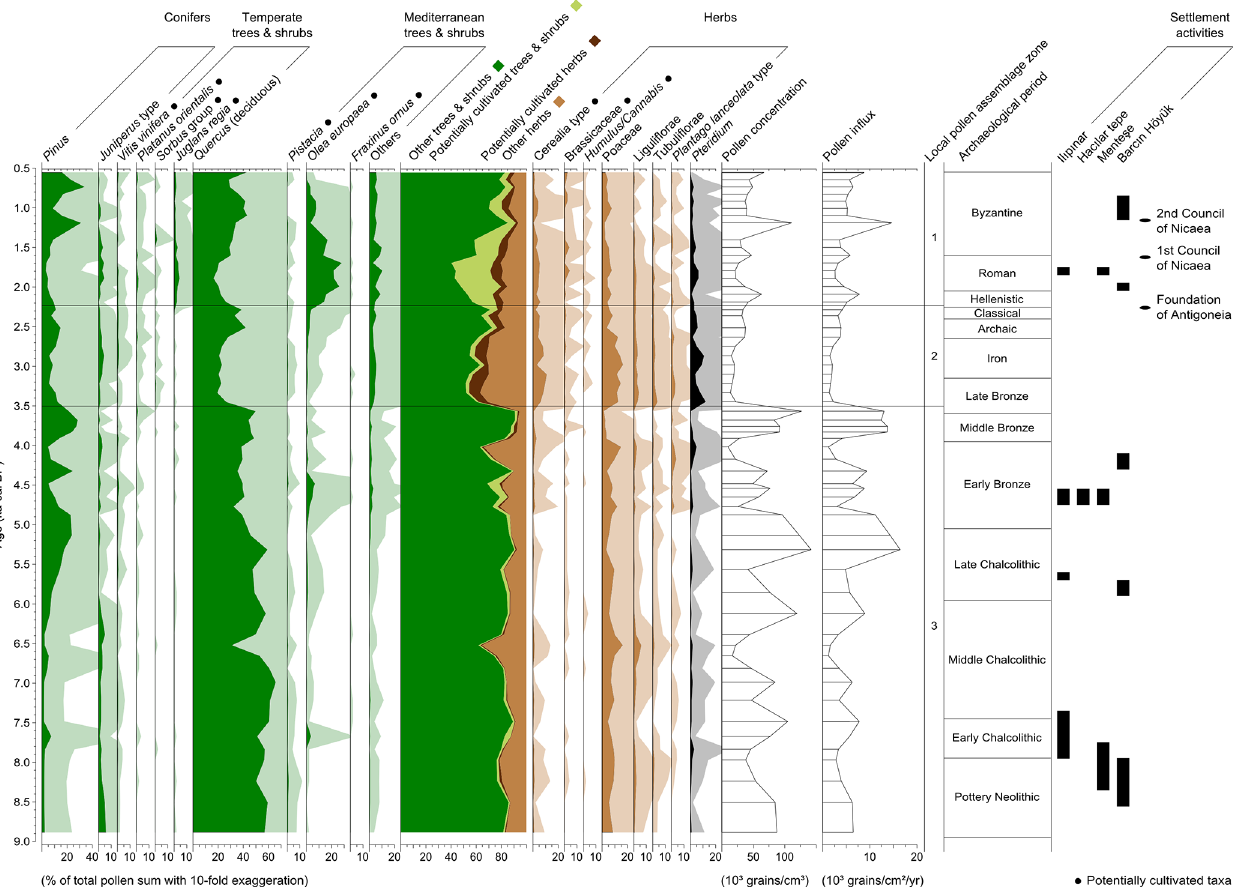
Figure 7. Pollen diagram of the last 9kacalBP inferred from Lake Iznik sediments with archaeological periods (Eastwood et al., 1998; Sagona and Zimansky, 2009), settlement activities of archaeological settlements in the vicinity of Lake Iznik (Ilıpınar, Hacılar tepe, and Mente¸se after Bottema et al. (2001) and Barcın Höyük after Gerritsen et al. (2013a, b); see Fig 8. for the locations), the foundation of Antigoneia (later Iznik; Abbaso˘glu and Delemen, 2003), and the two ecumenical councils of Nicaea (later Iznik; ¸Sahin, 2003).